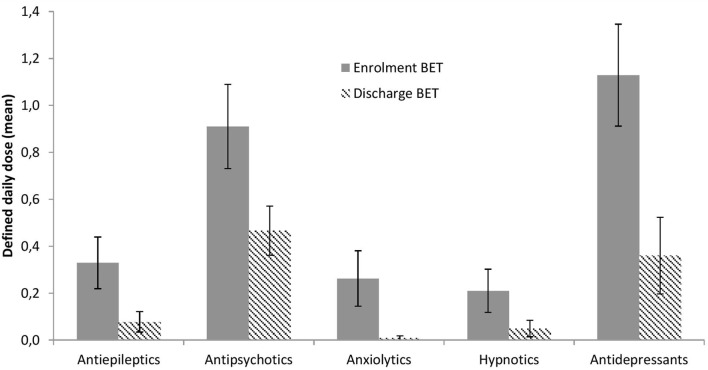
Changes in psychopharmacological treatment from enrollment to discharge. Lines are SEs.